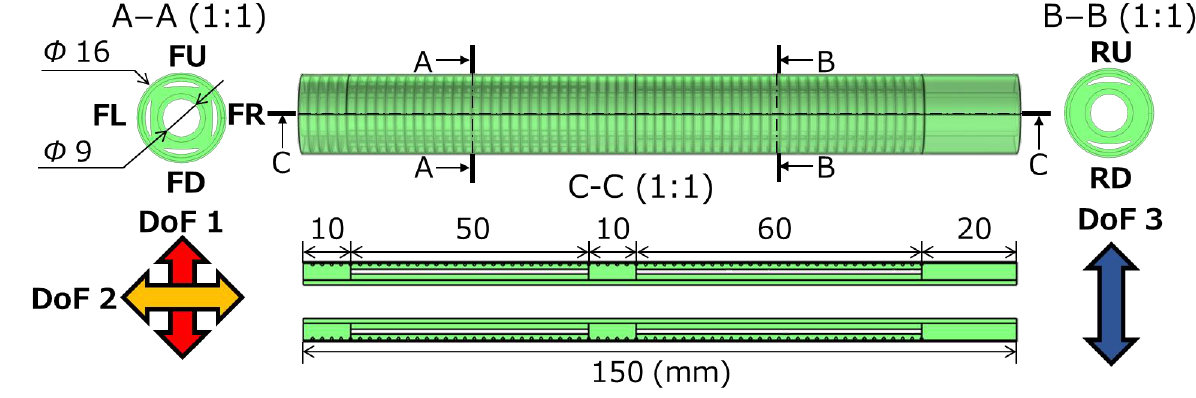
Figure A1. Investigated three-DoFs pneumatic soft actuator designs and parameters.